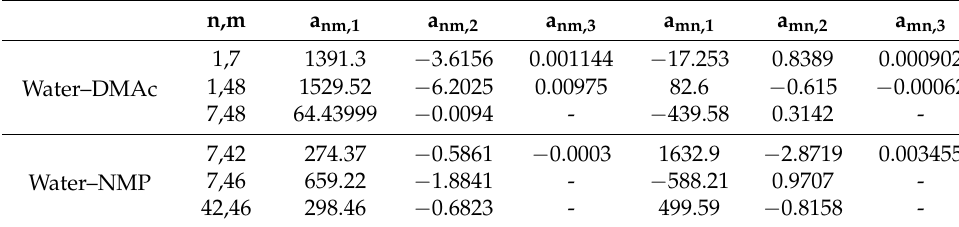
Table A3. Average values of cloud point data at the three temperatures for the four studied systems.